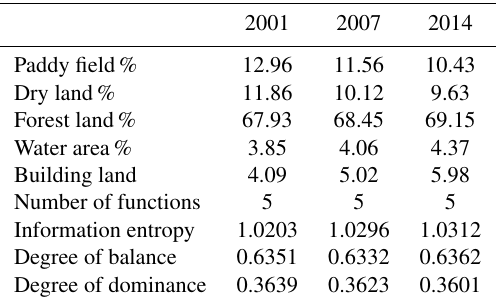
Table 3. Land use and cover structure, information entropy and de- gree of balance and dominance in the Qiantang River basin in 2001, 2007 and 2014.